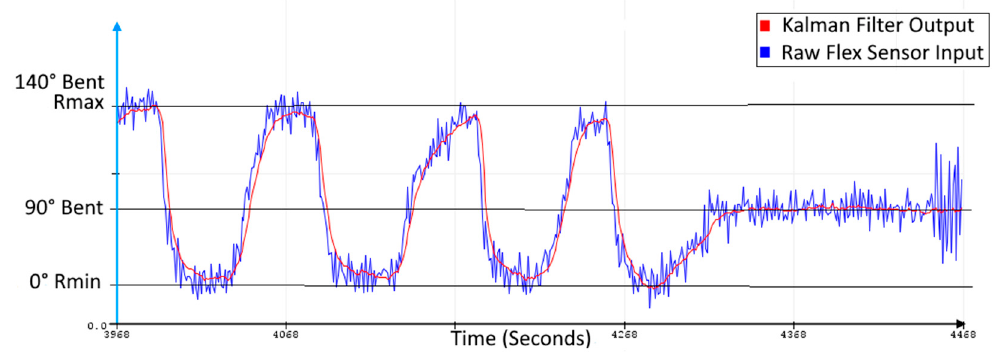
Figure 20. Kalman filter output.